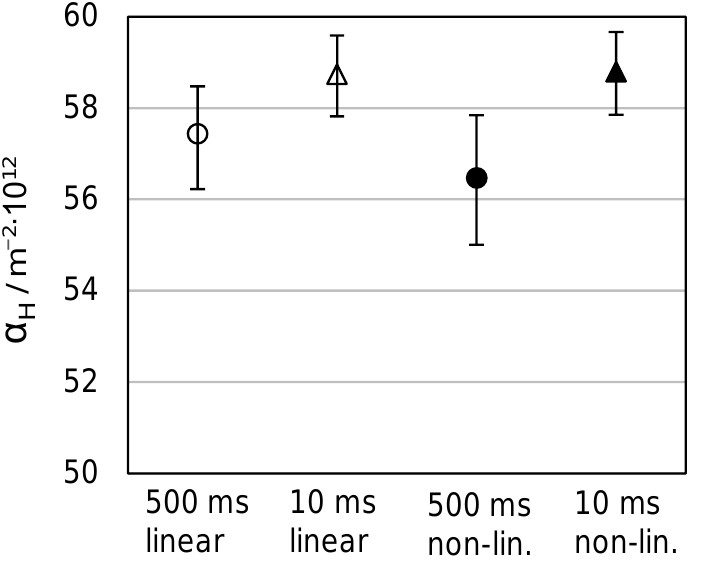
Figure 13. Effect on the filter medium resistance. Multifilament measured with 25 m% PCC at 0.8 bar.